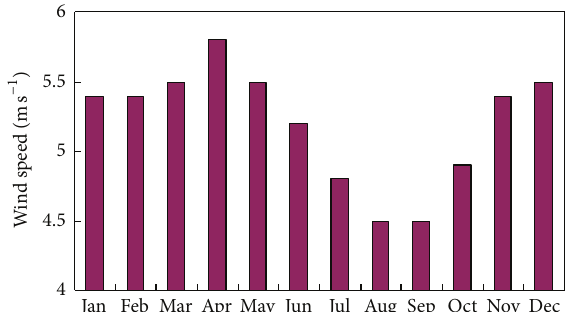
Figure 2: Monthly wind speed of Qingdao based on data of 1971–